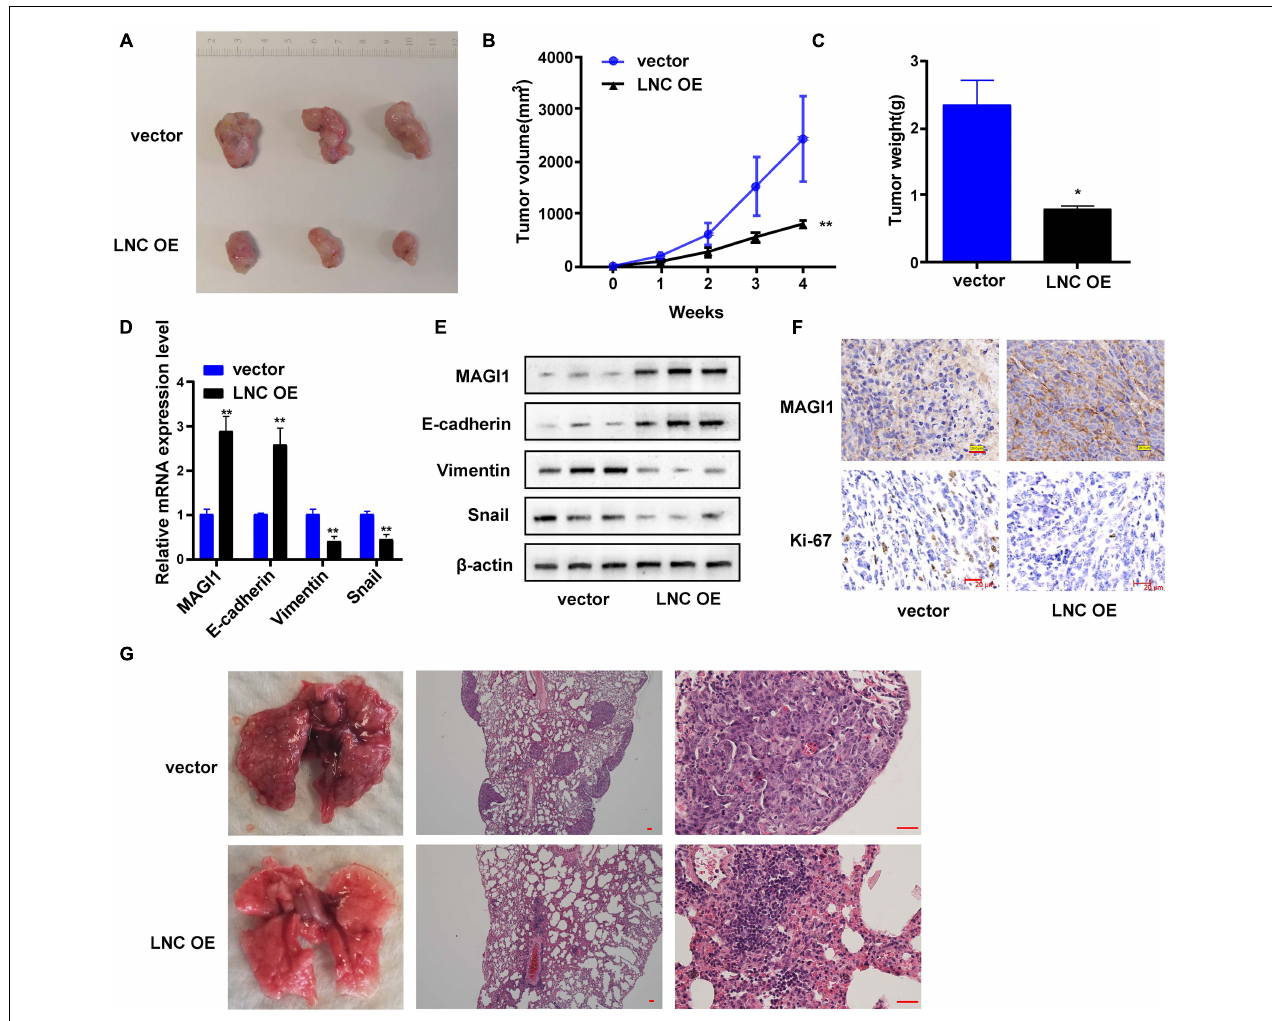
FIGURE 8 | TMEM220-AS1 overexpression limited the growth and metastasis of HCC in vivo. (A) Representative images of tumors from indicated orthotopic xenografts. (B) Tumor volume and (C) weight data of indicated orthotopic xenografts. (D,E) mRNA and protein expression levels of MAGI1 and EMT-related markers after TMEM220-AS1 overexpression. (F) The expression level of MEGI1 and Ki-67 determined using immunohistochemistry (bar = 20 µ m). (G) Representative images of lung metastases of indicated orthotopic xenografts (bar = 50 µ m). Data were presented as represent the mean ± SD; * P < 0.05, ** P <